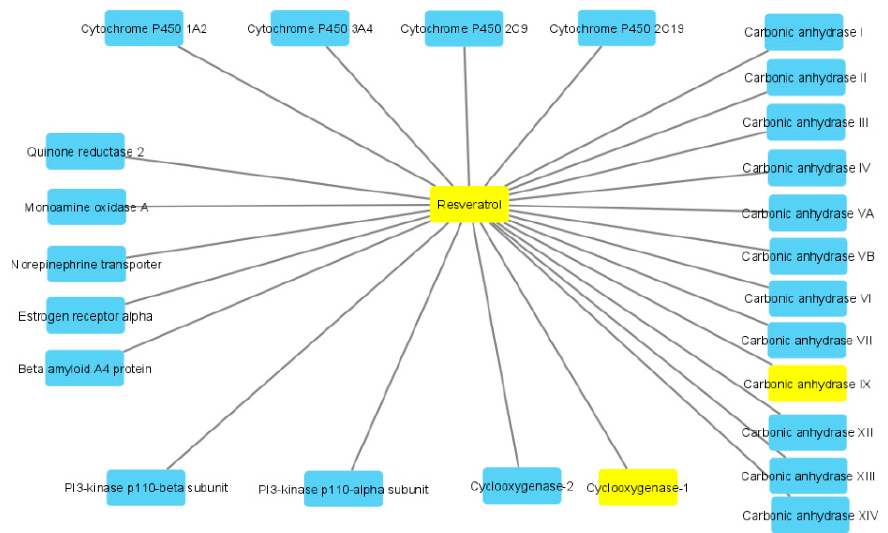
Figure 7. Targets–components analysis related to high probable putative interactions of resveratrol with multiple human proteins including cyclooxygenases and carbonic anhydrases.